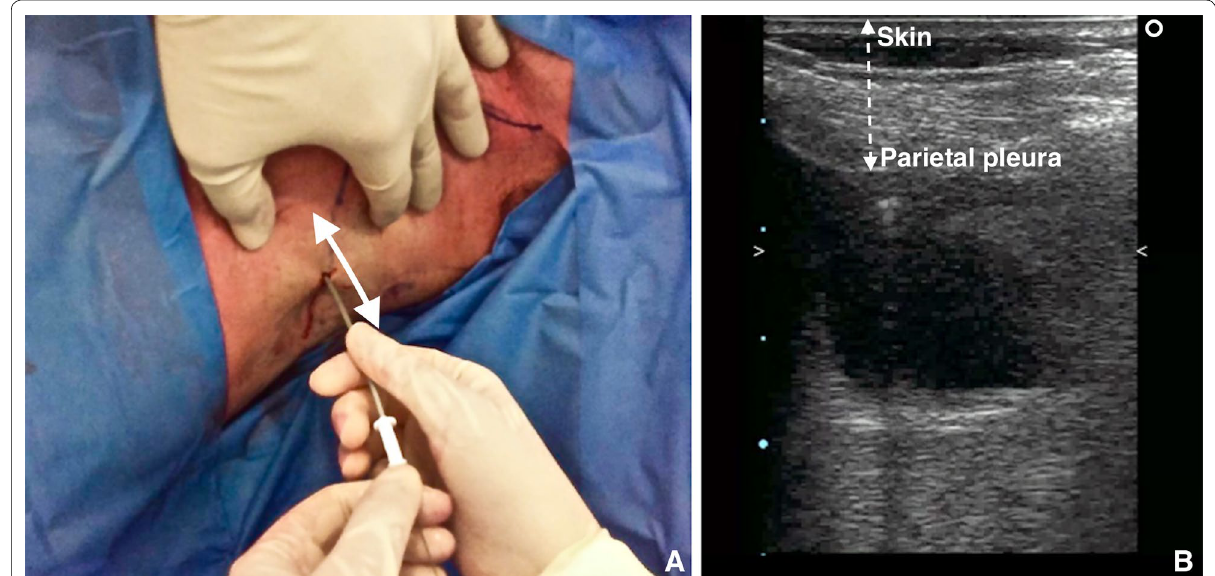
Fig. 6 A Using the high-frequency probe, it is possible to calculate the distance between the skin and parietal pleura. B The dilator should not be inserted further than 1 cm beyond the depth from skin to pleural